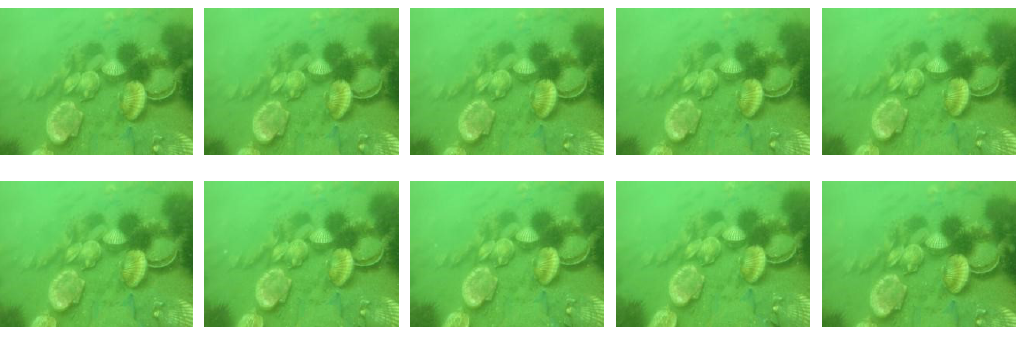
Figure 14. Experimental test